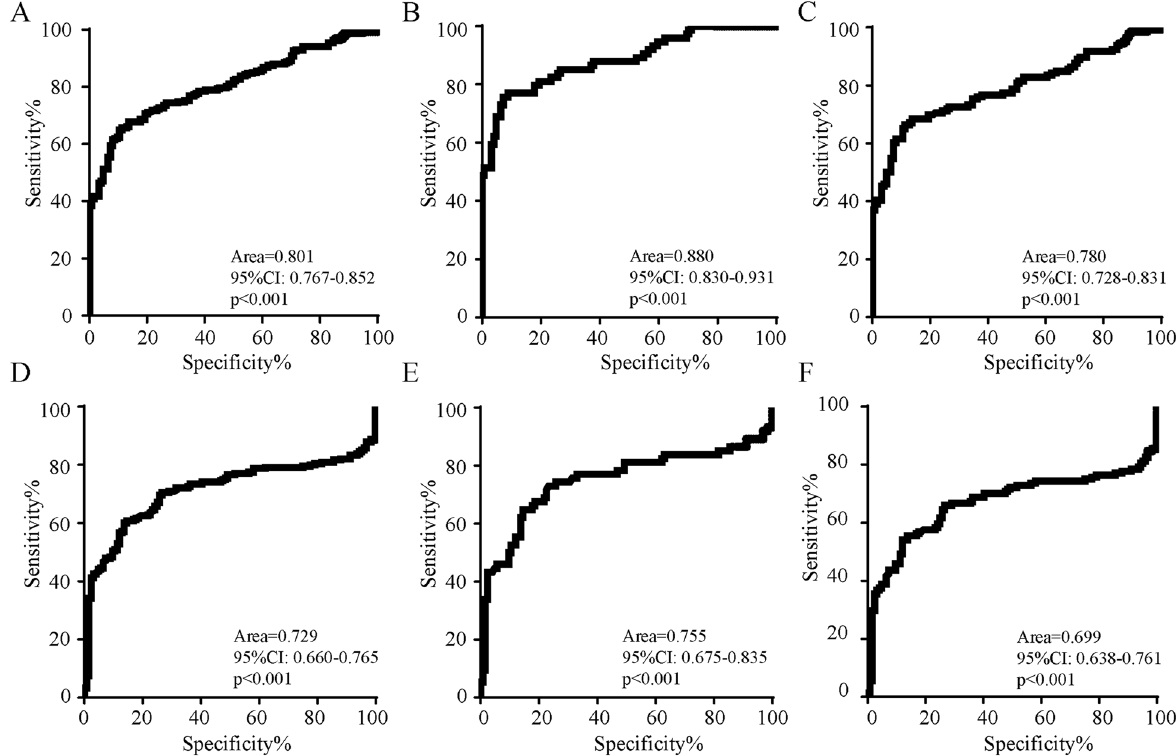
Fig. 2 ROC curve analysis of serum GDF-15 for diagnosis of ( A ) migraine, B CM, ( C ) EM from control group. ROC curve analysis of serum FGF-21 for diagnosis of ( D ) migraine, E CM, F EM from control group. CM: Chronic migraine; EM: Episodic migraine; ROC: Receiver operating characteristic